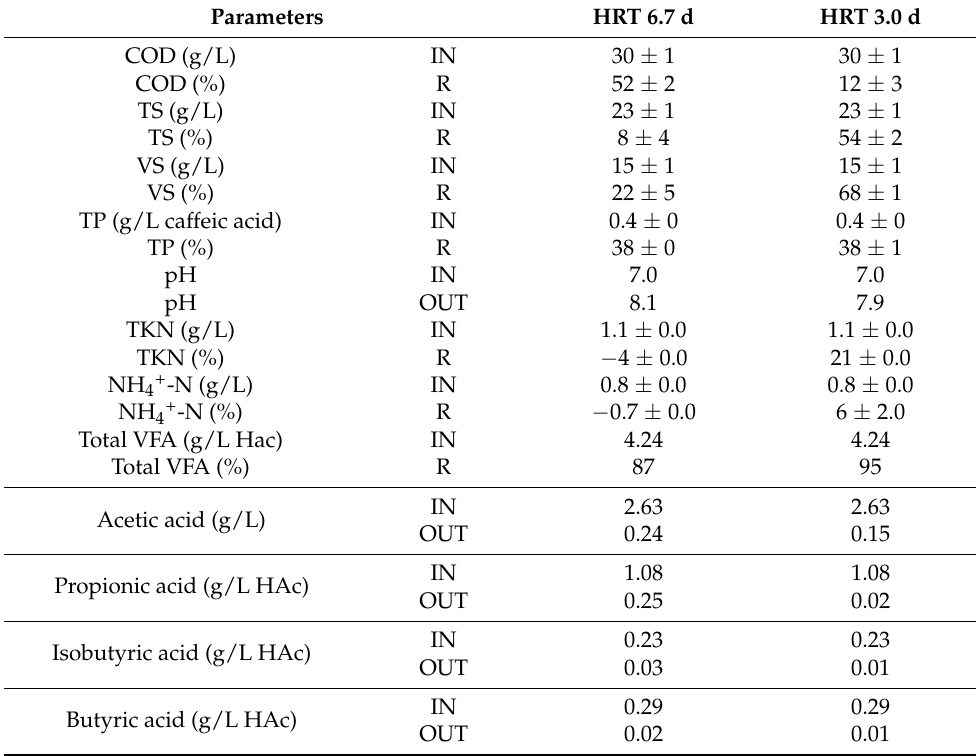
Table 3. Anaerobic digestion performance: brewery wastewater and piggery effluent